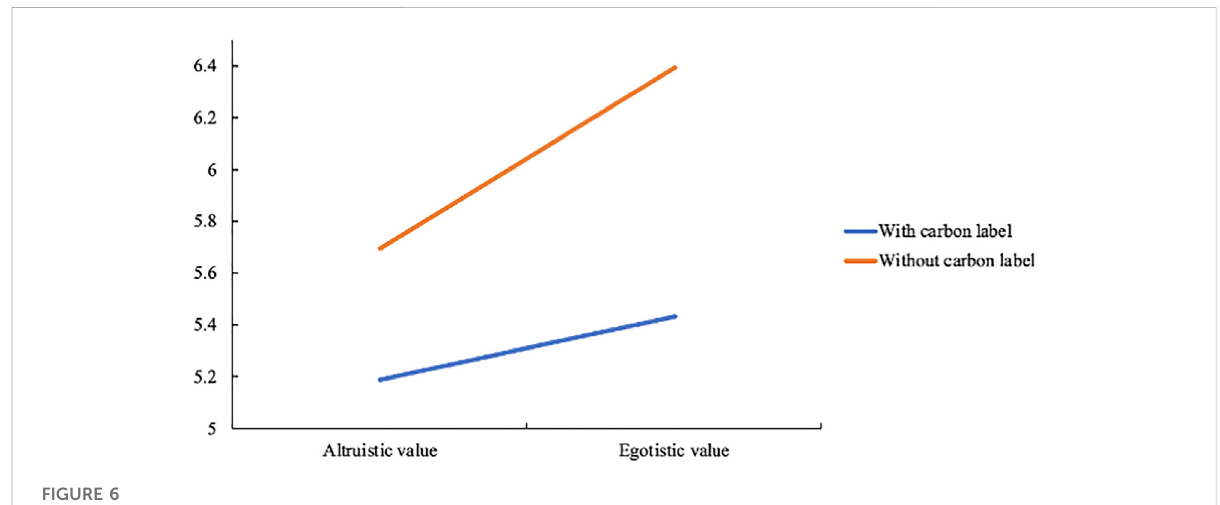
FIGURE 6 Moderating effect of the carbon footprint label.